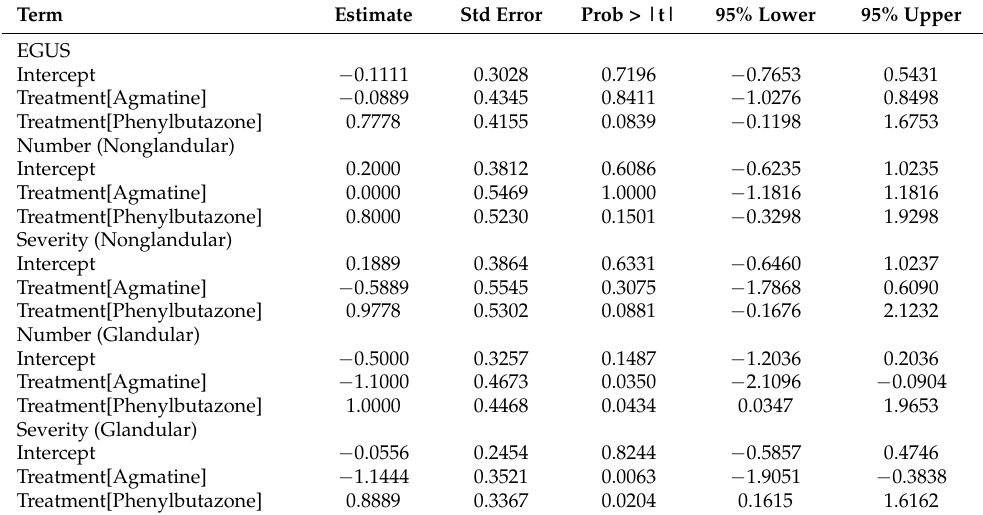
Table 9. Fixed effects parameter estimates of changes in gastric ulceration score. Std Error: standard interval upper limit.